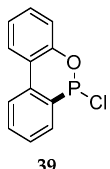
Figure 15. Phosphine oxide derivative 38 and its precursor 37 . 4. Flame Retardants with P-C aromatic Bonds In the following sections, we have summarized specific examples of P-C aromatic bond containing organophosphorus compounds, which are classified based on the synthetic strategy for creation of P-C bond. For clarity, the specific P-C bonds that were created in the structure have been marked in bold. 4.1. Friedel–Crafts Type Reactions One of the main routes to phosphorus-aromatic carbon bonds formation is a modified Friedel– Crafts reaction usually involving phosphorus trichloride and a Lewis acid. DOP-Cl (Compound 39 , Figure 16) has reportedly been synthesized starting from o- phenylphenol using phosphorus trichloride in presence of zinc chloride catalyst in 95% yield [66,77]. DOP-Cl is an important precursor for DOPO derivatives due to its high chemical reactivity towards nucleophiles [5] . As an example, it is shown in the literature that DOP-OMe reacts with hydroxymethyl substituted phenols via a Michaelis–Arbuzov type rearrangement to give compound 14 (Scheme 2) in 32% yield. Compound